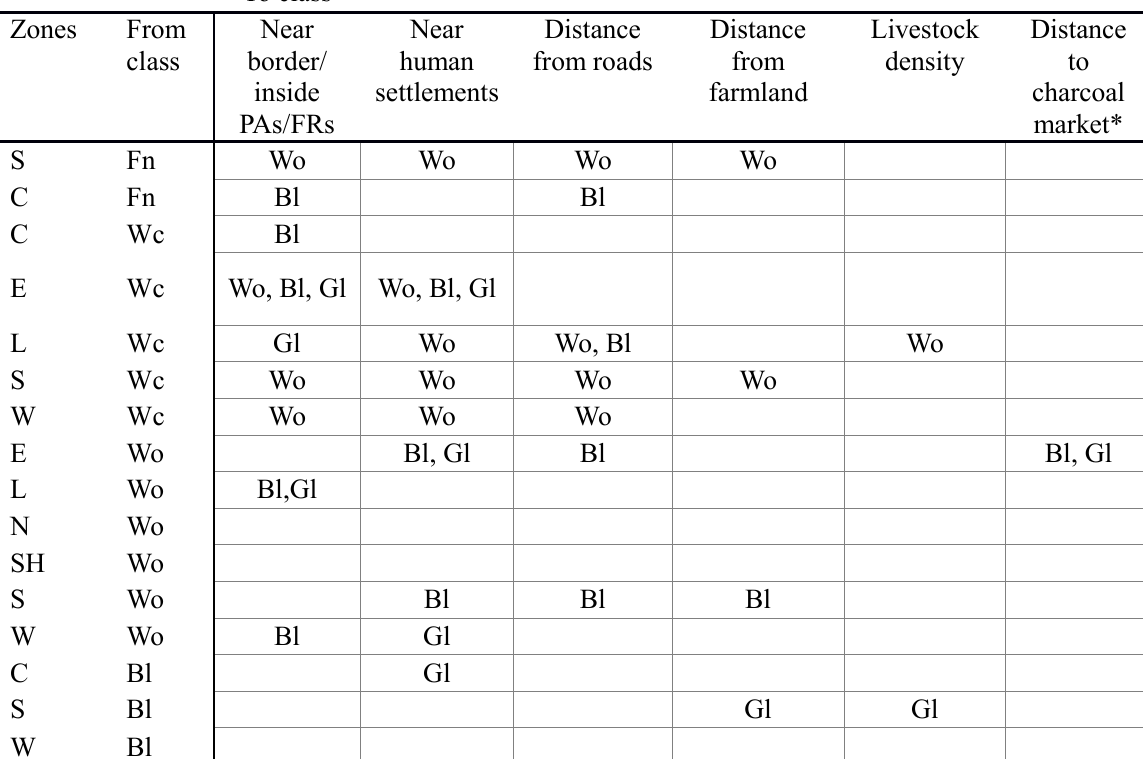
Table A2.1: Biophysical factors reported by stakeholders associated with (LULCC): a) from and to different wooded land-use-cover classes, and b) from the indicated classes to cultivated land. Crop suitability criteria were ranked by stakeholders during the national-level synthesis workshop (c, ranks in ascending order). Abbreviations: Fn, natural forest; Wc, closed woodland; Wo, open woodland; Bl, bushland; Gl,